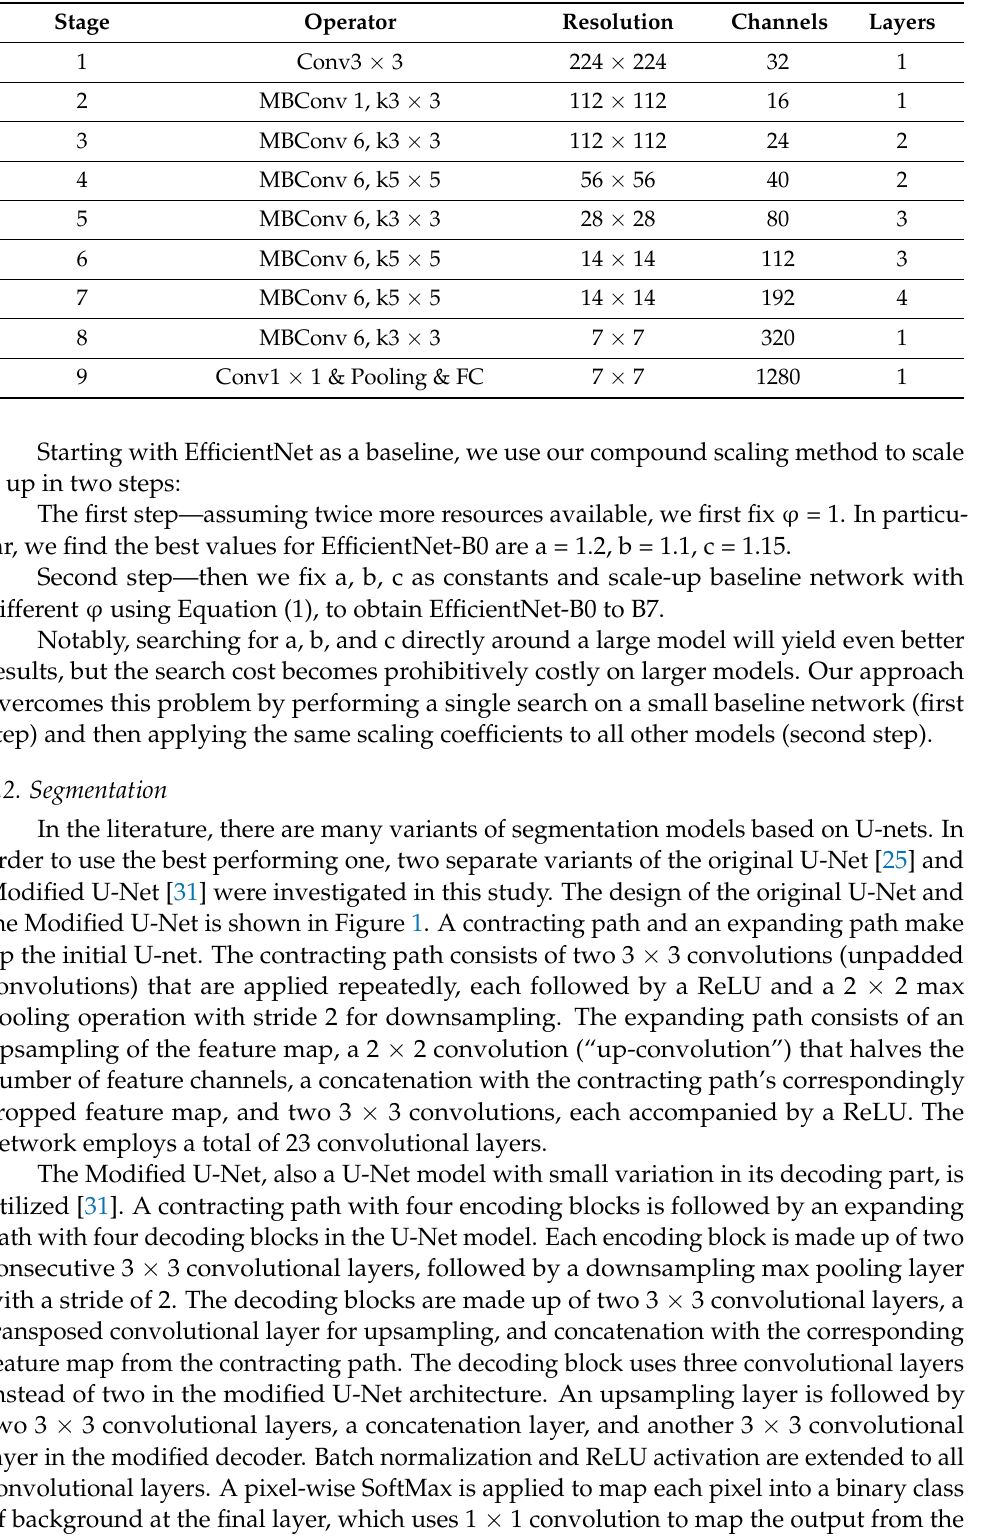
Table 1. EfficientNet baseline